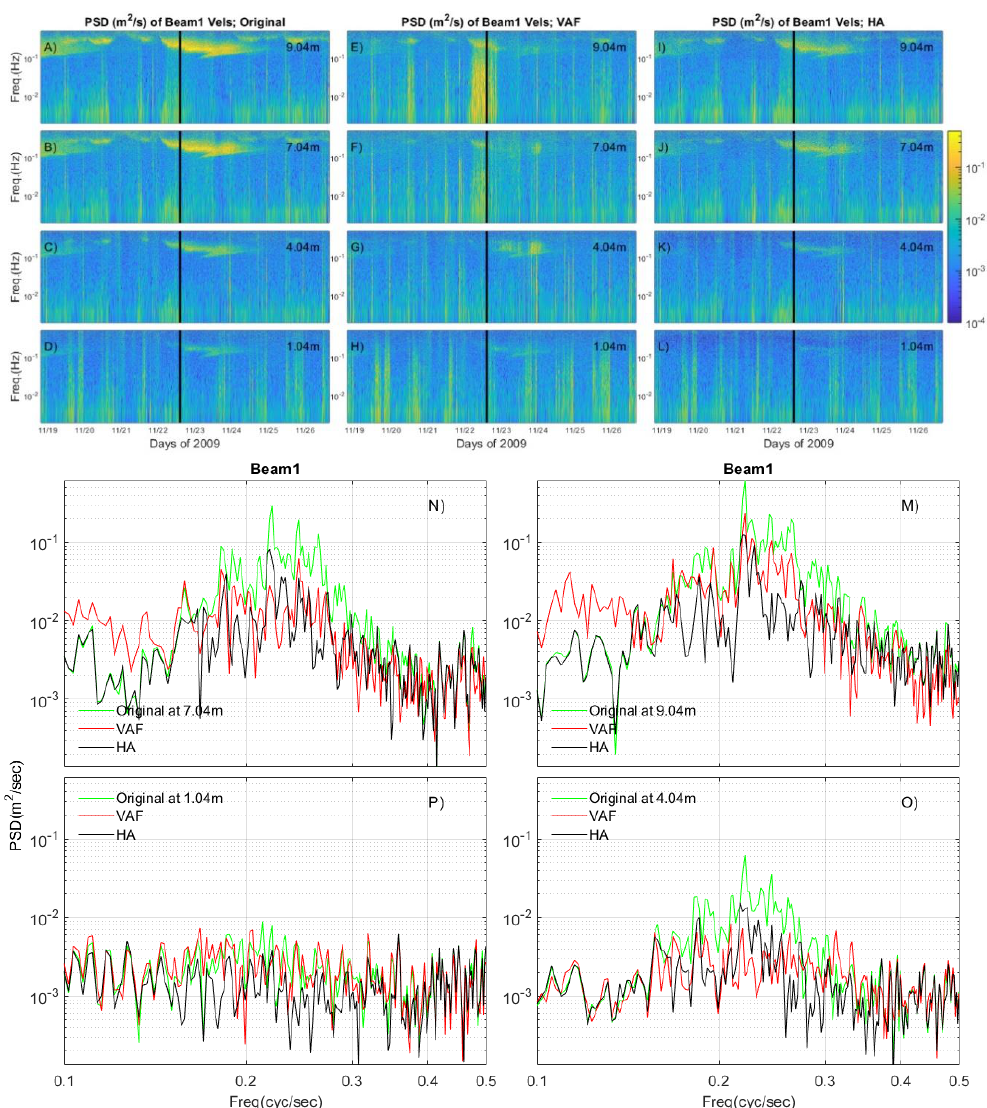
Figure 4. PSD (m 2 / s) of original Beam1 velocities (m / s) at ( A ) 9.04 m, ( B ) 7.04 m, ( C ) 4.04 m, and ( D ) 1.04 m above the bottom; PSD of Beam1 velocities of the Vertical Adaptive Filtering (VAF) method at ( E ) 9.04 m, ( F ) 7.04 m, ( G ) 4.04 m, and ( H ) 1.04 m and PSD of Beam1 velocities of the HA method ( I ) 9.04 m, ( J ) 7.04 m, ( K ) 4.04 m, and ( L ) 1.04 m. Line plots: ( M – P ), show the PSD corresponding to the black vertical line in the contour plots.